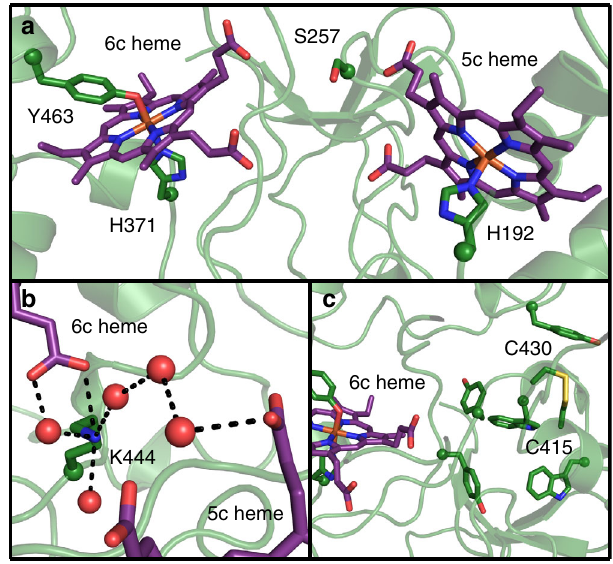
Fig. 4 Structure of BthA. a Ser257 is positioned between the 6c heme, coordinated by His 371 and Tyr463, and the 5c peroxidatic heme, coordinated by His 192. b Lys444 mediates a water network between the propionate groups of the 5c and 6c hemes. c An intramolecular disul fi de between Cys415 and Cys430 is located near the 6c heme and is surrounded by tyrosine and tryptophan residues. Peptide and heme carbon shown in green and purple, respectively. Oxygen, nitrogen, sulfur, and iron shown in red, blue, yellow, and orange, respectively. Peptide backbone shown in cartoon representation and sidechains and hemes shown in stick representation. Side-chain α -carbon and water shown as